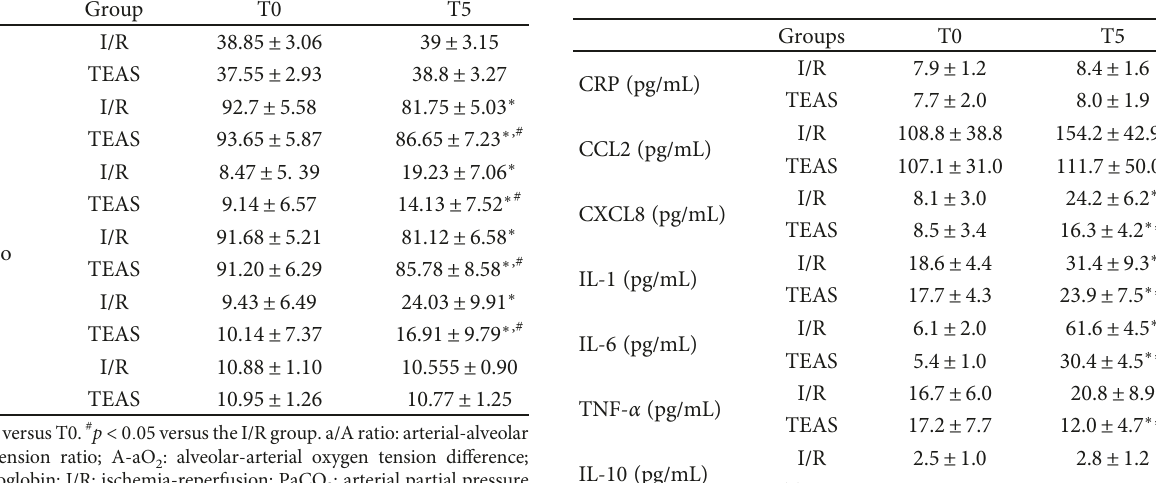
Table 4: Plasma CRP, CCL2, CXCL8, IL-1, IL-6, TNF- α , and IL-10 levels ( n = 20 in each group). Data are expressed as mean ± standard